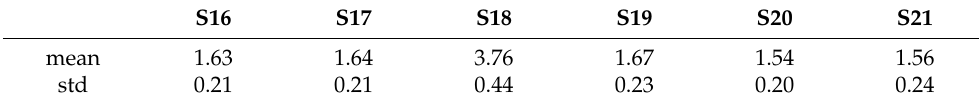
Table 5. Comparison of estimation accuracy in the last six examined scenarios in Section